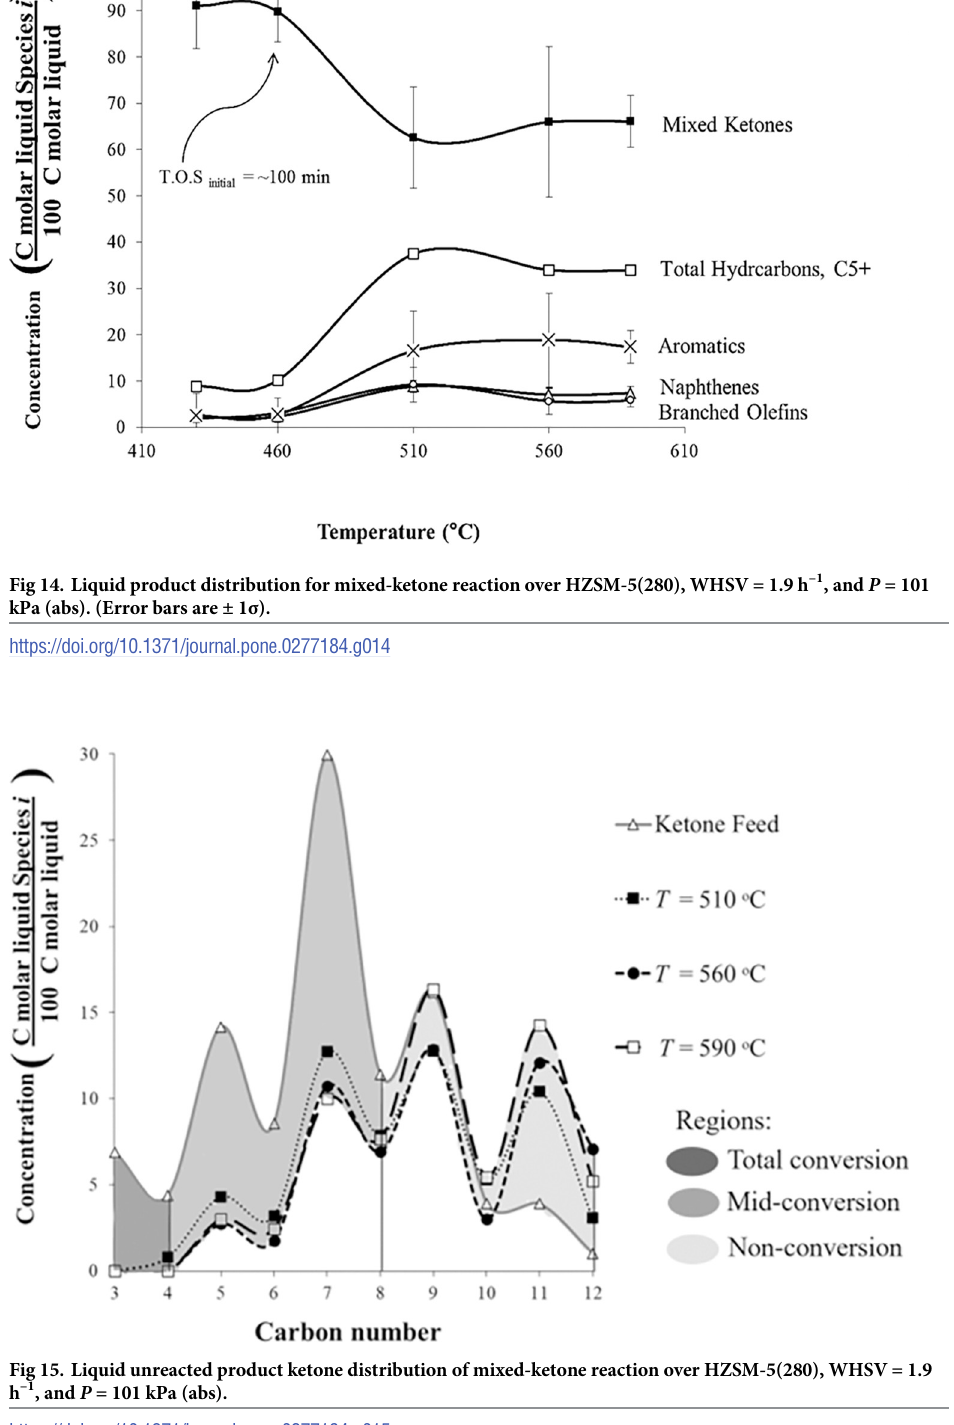
PLOS ONE | https://doi.org/10.1371/journal.pone.0277184 November21,